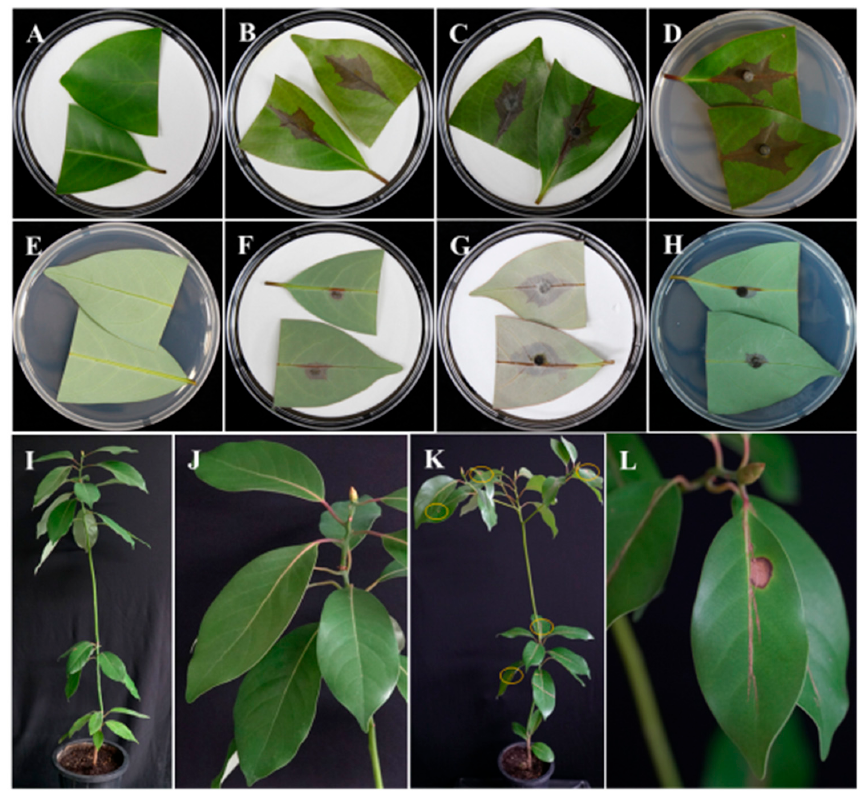
Figure 3. Pathogenicity tests of Neofusicoccum parvum on the detached leaf and whole plants of Machilus thunbergii . Detached leaf pathogenicity of N. parvum ; Control adaxial ( A ), abaxial sides ( E ). Fungus inoculated on adaxial and abaxial sides of the leaves by filter paper spore suspensions (FPS) ( B , F ), filter paper plug (FPP) ( C , G ), or water agar plug (WAP) ( D , H ) methods, and cultured at 25 °C for 5 days in moistened conditions. Pathogenicity of whole plants 12 days after inoculation in culture room conditions; control sprayed with distilled water—whole plant (left) and larger view ( I , J ); N. parvum sprayed on leaves—whole plant ( K ) and infected leaves in large view ( L ). Circle indicates symptomatic leaves ( K ).